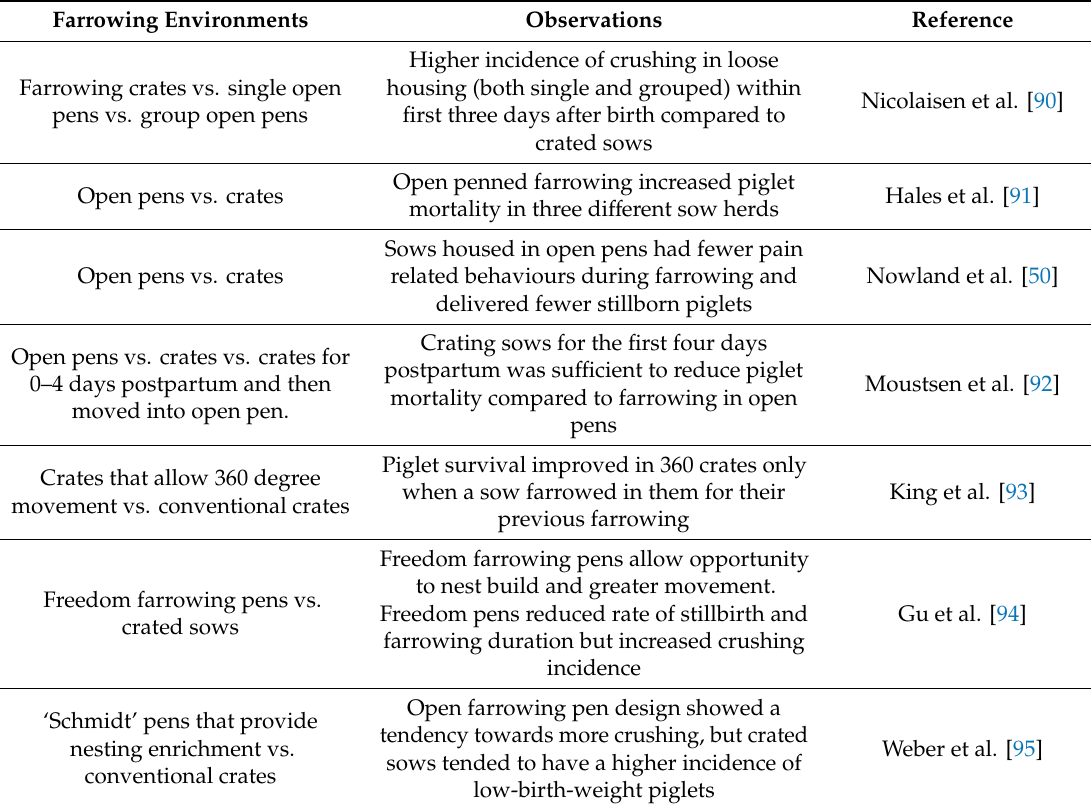
Table 1. Alternative farrowing environments and their influence on sow and / or piglet performance. Farrowing Environments